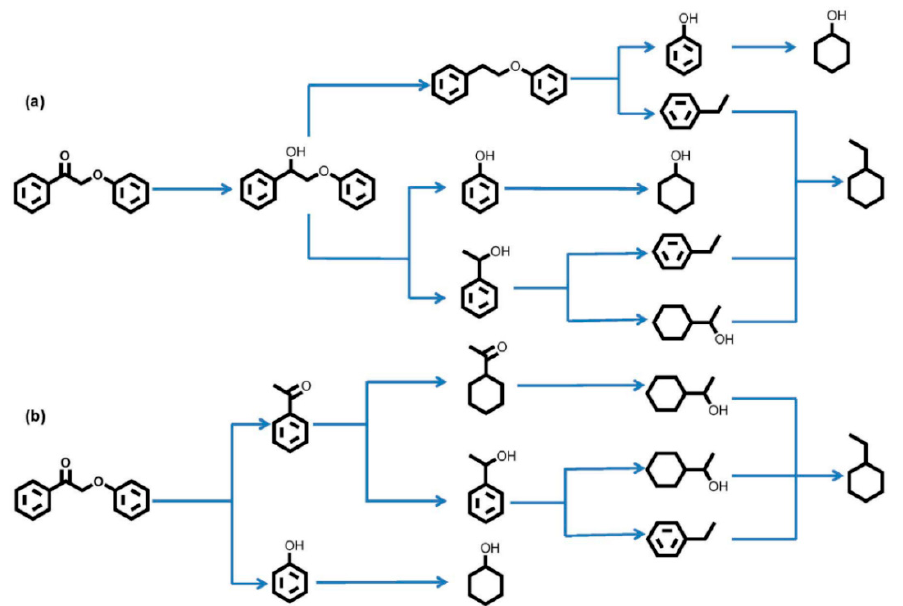
Figure 10. Proposed reaction pathways of 2-phenoxy-1-phenylethanone conversion on Ni/ZnO-Al 2 O 3 -5 form ref [42] .